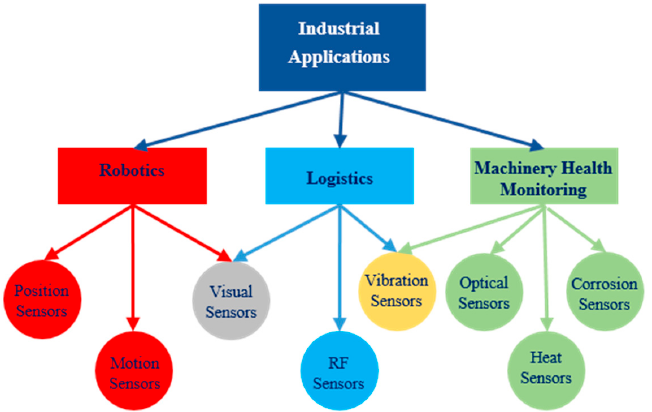
Figure 14. The subcategories of the industrial applications of WSNs and the types of the sensors used in them.